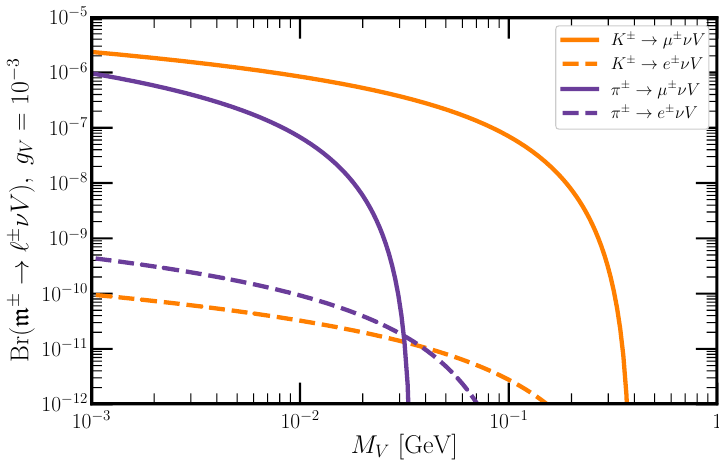
Figure 33 . Branching fractions for gauge boson V production for g V = 10 (cid:0) 3 via the decays ‘ (cid:6) (cid:23)V , with orange lines representing kaon decays and purple lines representing pion decays. m (cid:6) ! Solid lines are for ‘ = (cid:22) and dashed are for ‘ = e